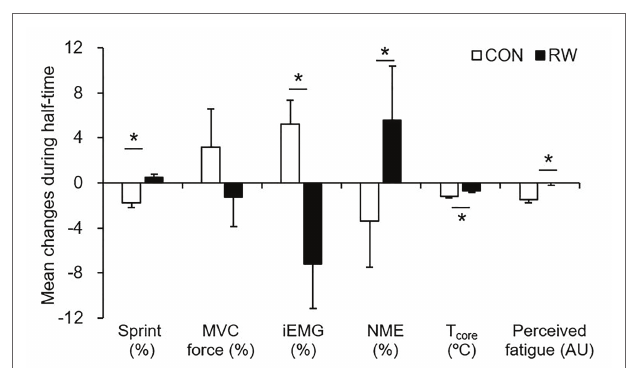
FIGURE 3 | The mean changes during half-time of sprint performance, MVC force, iEMG, neuromuscular efficiency (NME), gastrointestinal temperature (T core ), and perceived fatigue. CON: 15-min seated rest trial, RW: 1-min re-warm up at high-intensity trial [ n = 12 (T core : n = 5), mean ± SD]. *Significant difference between the trials ( p <